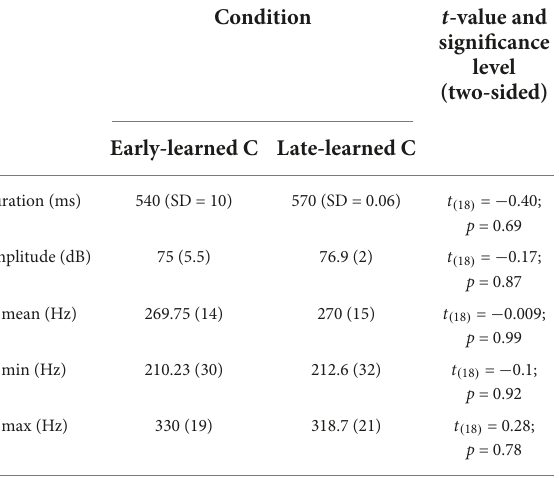
TABLE 5 Experiment 2: acoustic characteristics of the